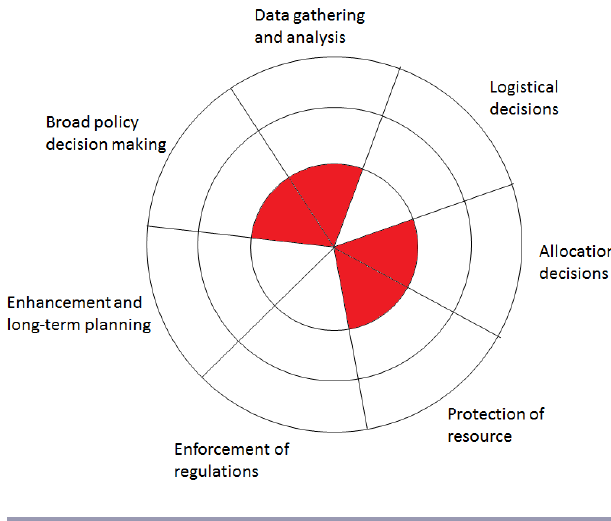
Fig. 4 . The combined contribution of the water abstractor groups, i.e., Lark, Broadlands Agricultural Water Abstractor Group, East Suffolk Water Abstractor Group, and Nar, to Pinkerton’s seven comanagement